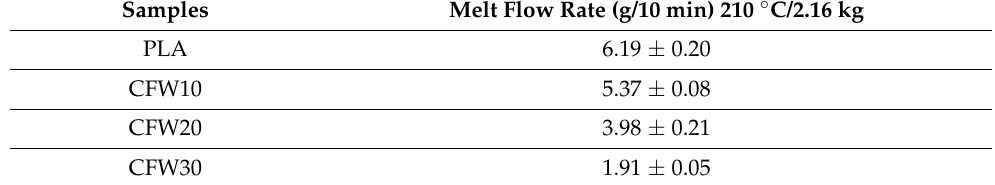
Figure 1. CFW pellets. Table 1. The melt flow index.